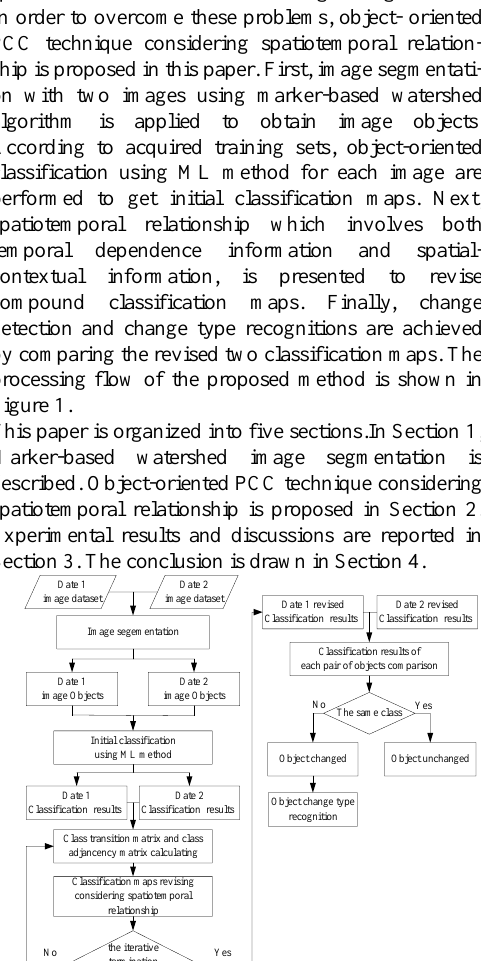
Figure 1. Schematic representation of the proposed technique